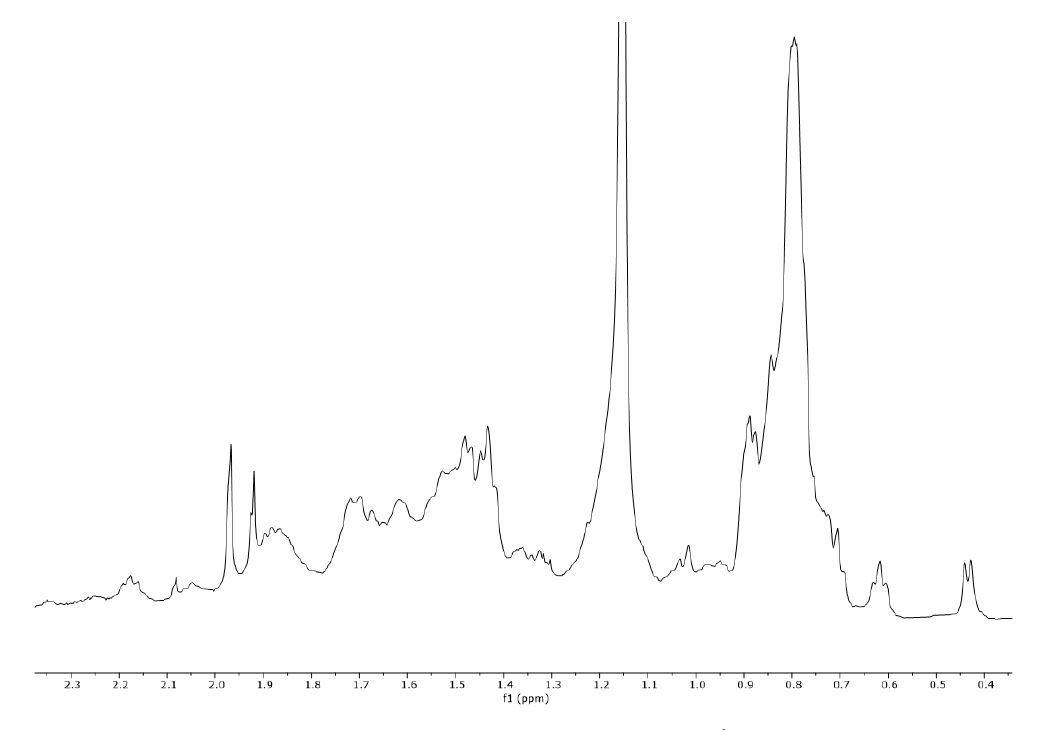
Figure 9. Expanded region C (δ = 0.4 –2.3 ppm) of a 1 H-NMR spectra (500 MHz, CD 3 OD) of Vespa velutina venom obtained by electrical stimulation.